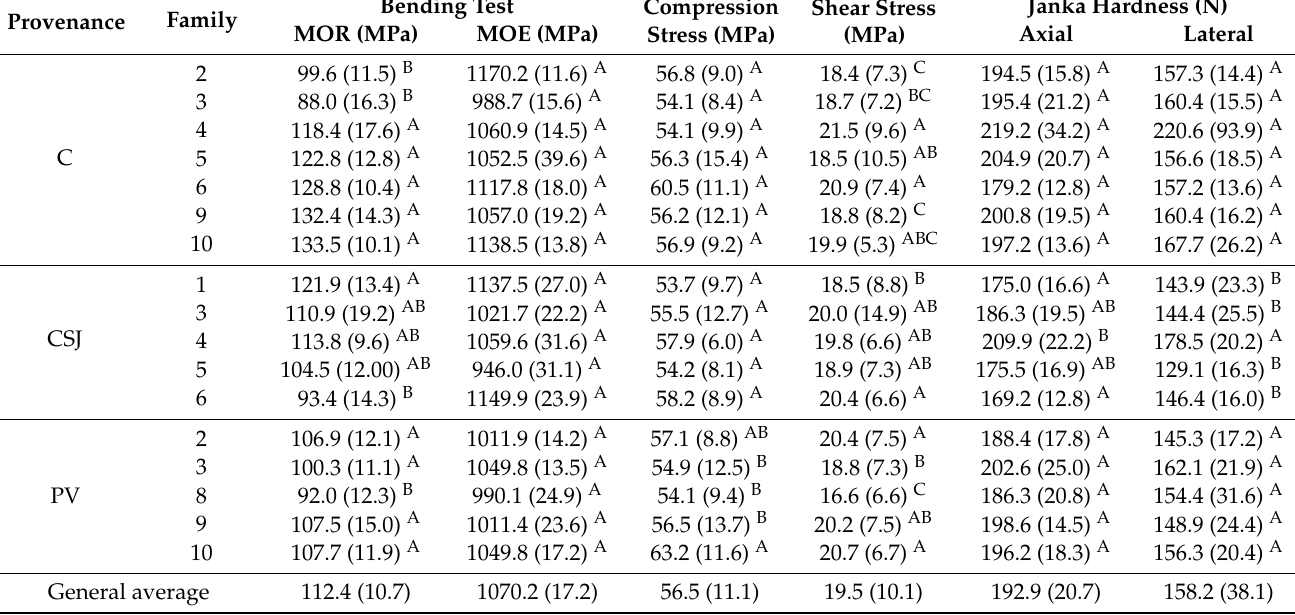
Table 3. Mechanical properties at 8-years-old among native provenances and families of Dipteryx panamensis in Costa